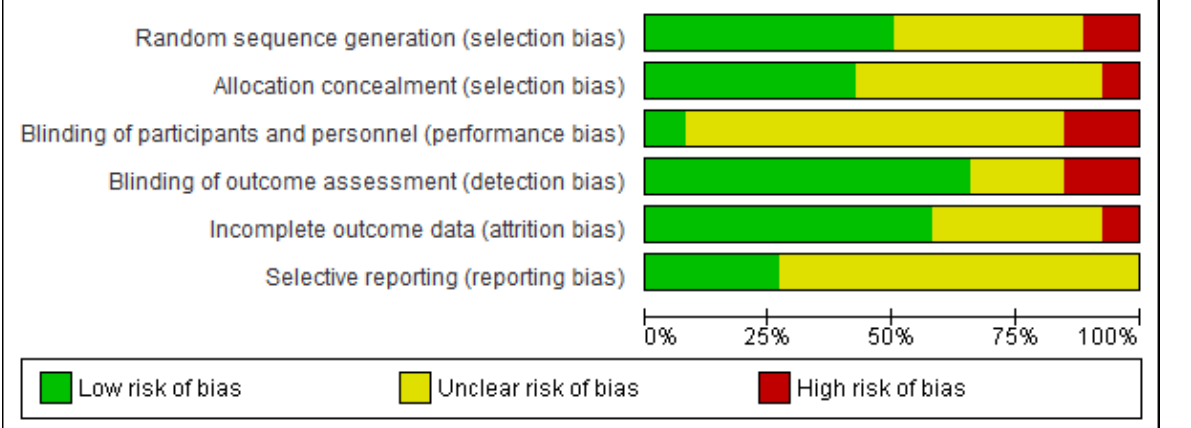
Figure 2. Percentages of risk of bias found in the studies considered in the present review.